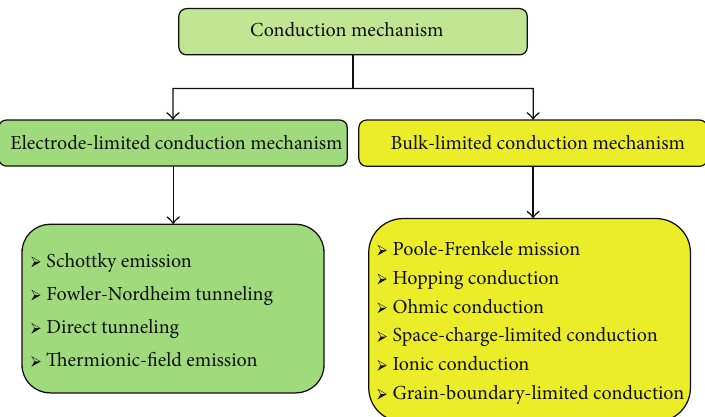
Figure 1: Classification of conduction mechanisms in dielectric